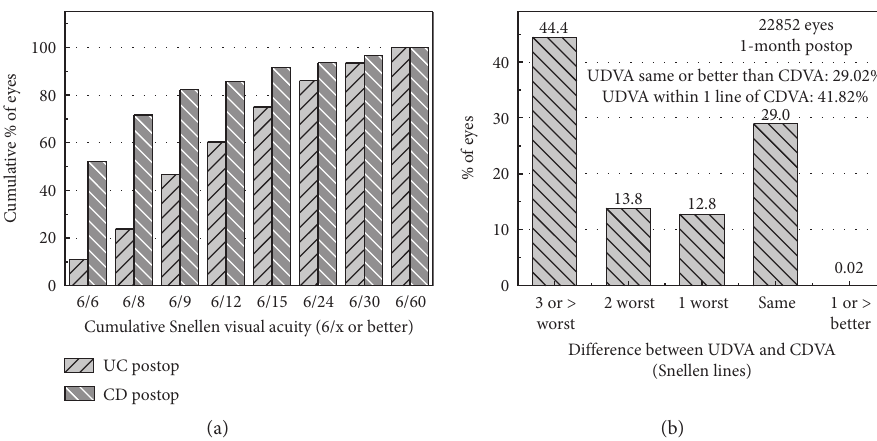
Figure 9: Distribution of the postoperative visual acuity (both uncorrected distance UD and corrected distance CD). (a) The percent of eyes with a given visual acuity. (b) Differences between UD and CD in terms of Snellen lines.